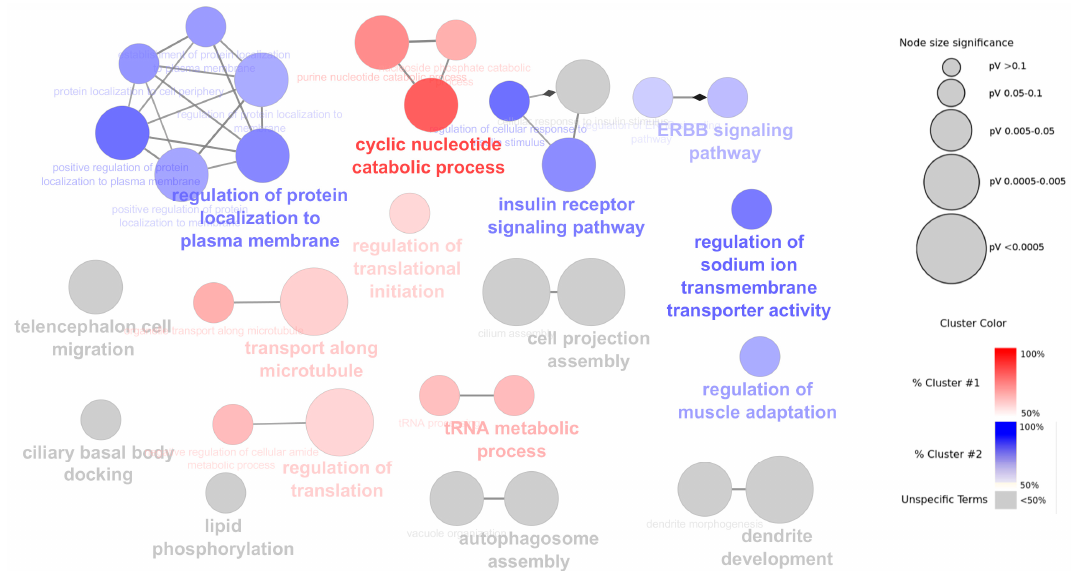
Figure 6. Enriched gene ontology (GO) terms for α - and β -cell selective circRNA host genes. GO terms (biological process) associated with Cluster 1 ( β -cell) circRNA host genes are shown in red, Cluster 2 ( α -cell) circRNA host genes in blue, and common terms for both clusters are shown in grey.